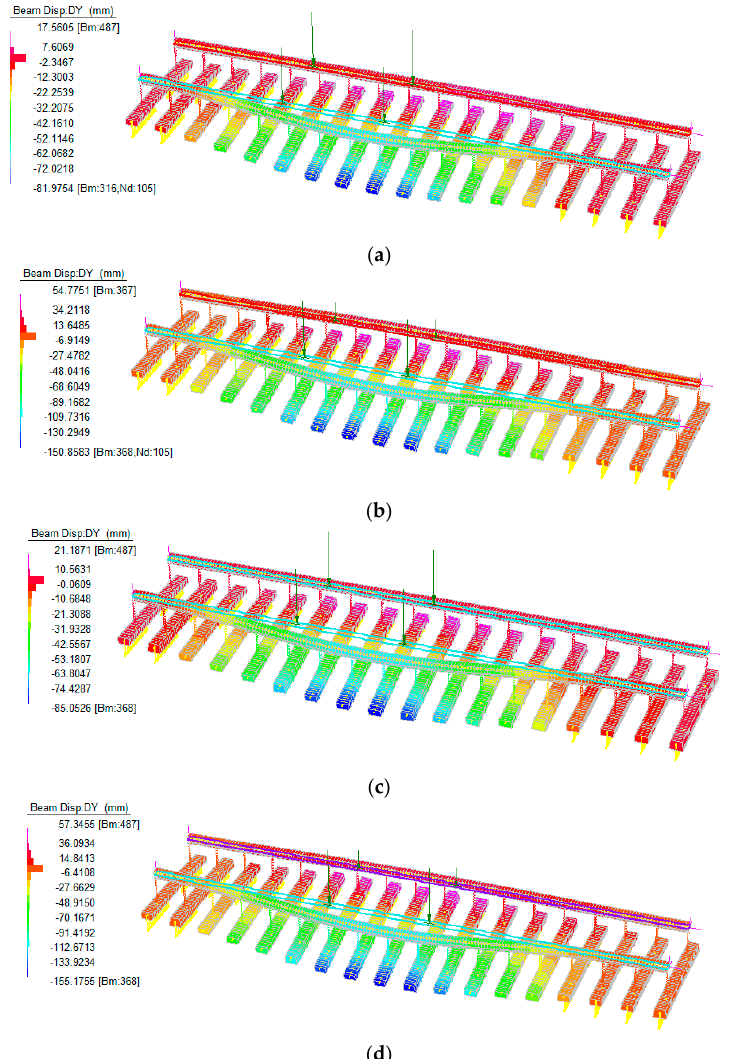
Figure 11. Dynamic track response under different track support states and axle loads at 60 km/h. ( a ) timber track with even axle loads and largescale loss support, ( b ) timber track with uneven axle loads and large–scale loss support, ( c ) 1in4 track with even axle loads and large–scale loss support and ( b ) 1in4 track with uneven axle loads and large–scale loss support. The short and long twist limits are listed in Table 2 according to the Australian rail- way maintenance manual [55]. The twist limit values for low-speed railway lines are higher than high-speed lines. The defects are categorised into six standard defect catego- ries: N (Normal), P3 (Priority 3), P2 (Priority 2), P1 (Priority 1), E2 (Emergency 2) and E1 (Emergency 1). For each defect condition, the repair action and track response inspection should be executed within a limited period, as presented in Table 3. If the track is under E conditions (E1/E2), the running train is prone to derail and the track system needs to be maintained for better track quality before the next train operation.